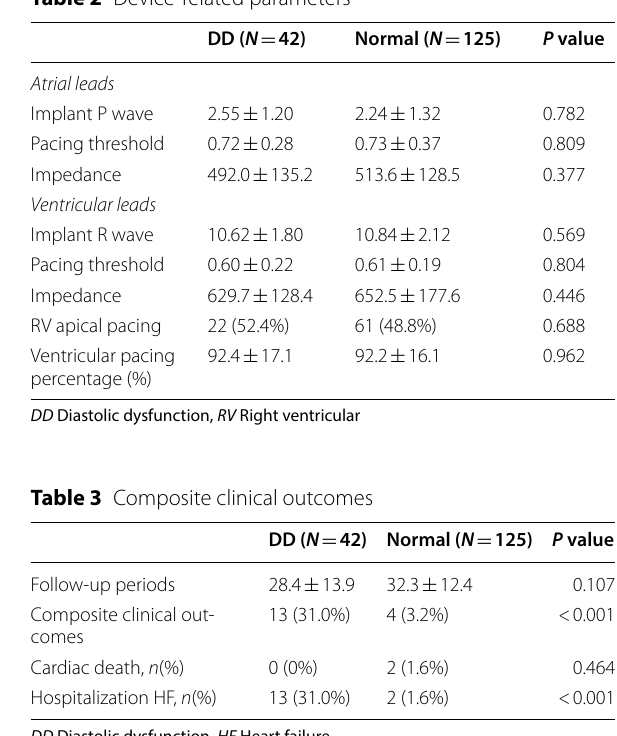
Table 4 Predictors of composite clinical outcomes using cox proportional hazard model